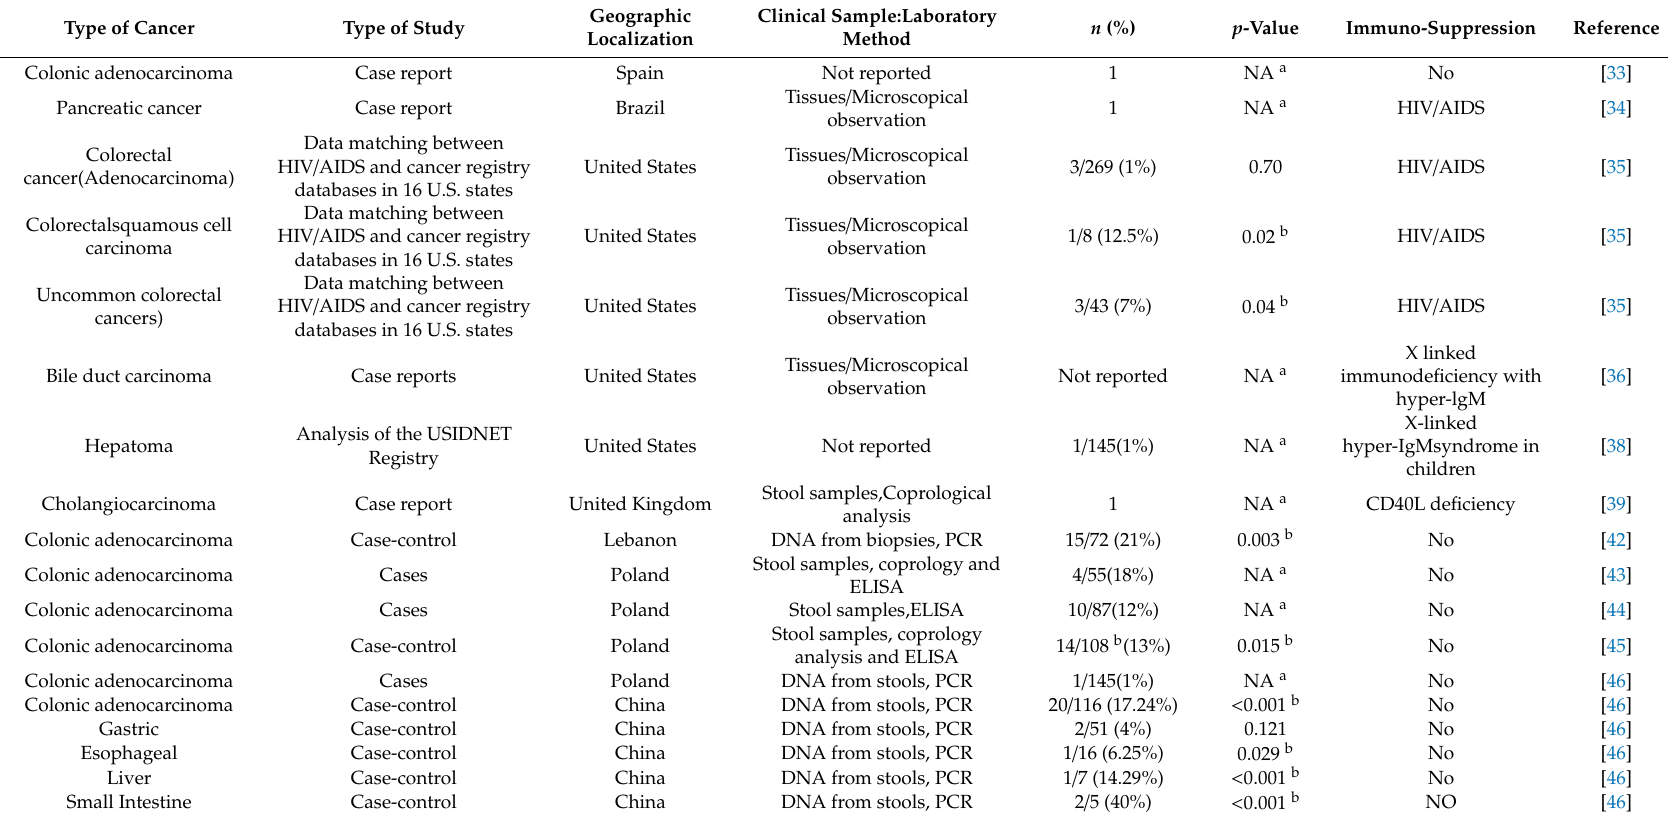
Table 1. Associations between Cryptosporidium infection and human digestive neoplasia in di ff erent